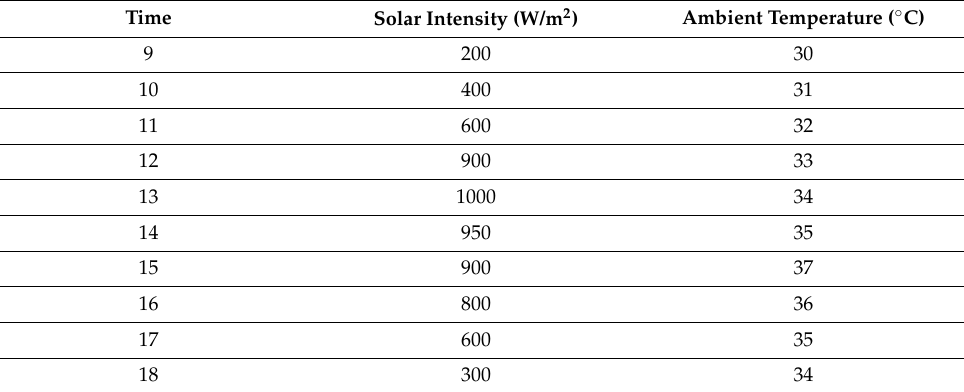
Table 4. Weather conditions of the PVT air collector [43].